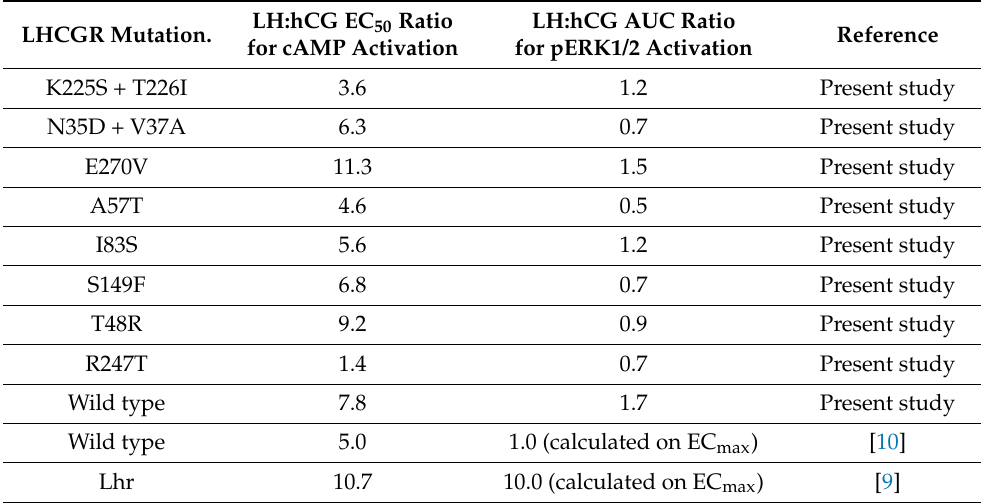
Table 4. LH:hCG ratio from E50 for cAMP activation, and AUC of pERK1/2 kinetics, mediated by LHCGR. Data were calculated from Tables 1 and 2 of the present study where indicated. LHCGR Mutation.